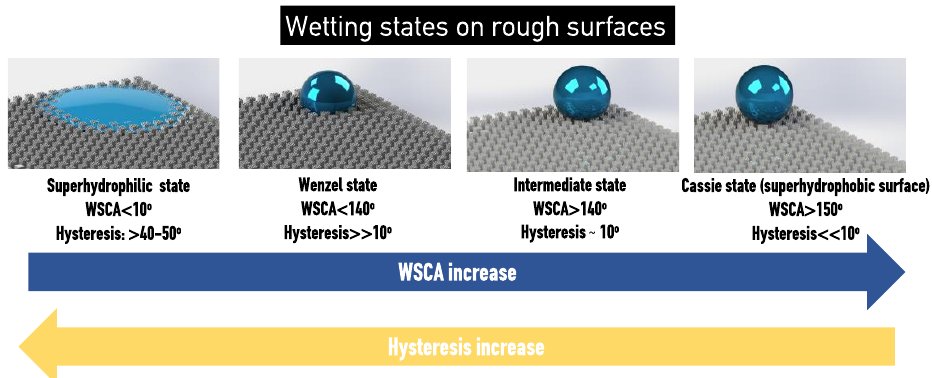
Figure 2. Wetting states of rough surfaces and respective wetting characteristics (WSCA and